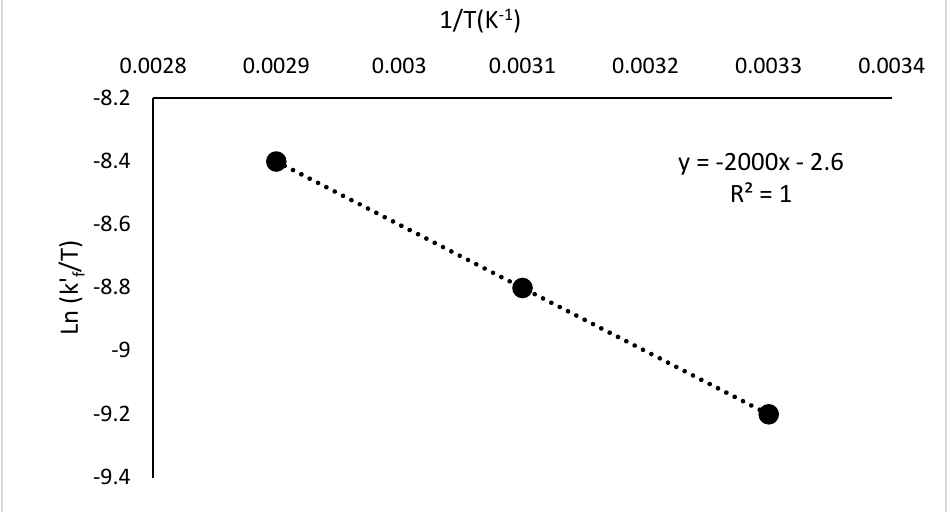
Figure 8. ln k (cid:48) versus 1/T plot for Eyring thermodynamics parameters. Table 5. Values of enthalpy and entropy change for Chlorella vulgaris in-situ transesterification process. Thermodynamic Properties